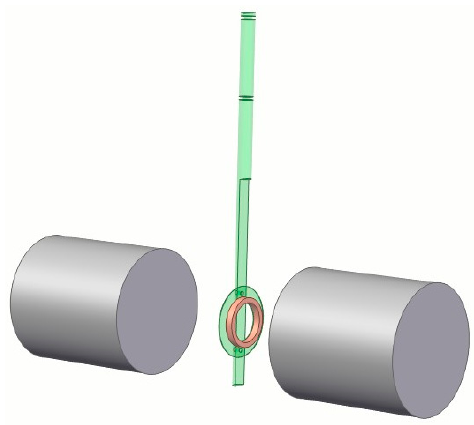
Figure 2. Schematic view of the experimental setup; the cylinders represent the magnet poles. The coil is fixed by a non-magnetic nut in the center of the two magnet poles.